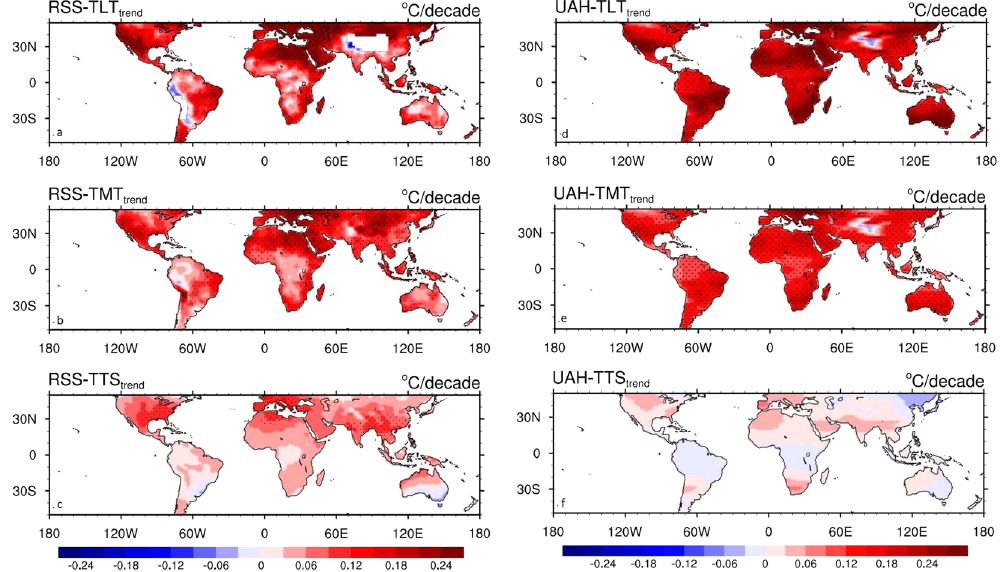
Figure 4. Spatial patterns of annual temperature trends (°C/decade) from ( a ) RSS-TLT, ( b ) RSS-TMT, ( c ) RSS- TTS, ( d ) UAH-TLT, ( e ) UAH-TMT and ( f ) UAH-TTS for the period 1979–2015, in 2.5° × 2.5° grid boxes over land. Stippling indicates regions where temperature trends are statistically significant (p < 0.1). Map was created using the NCAR Command Language (Version 6.0.0) [Software]. (2011). Boulder, Colorado: UCAR/NCAR/ CISL/TDD.